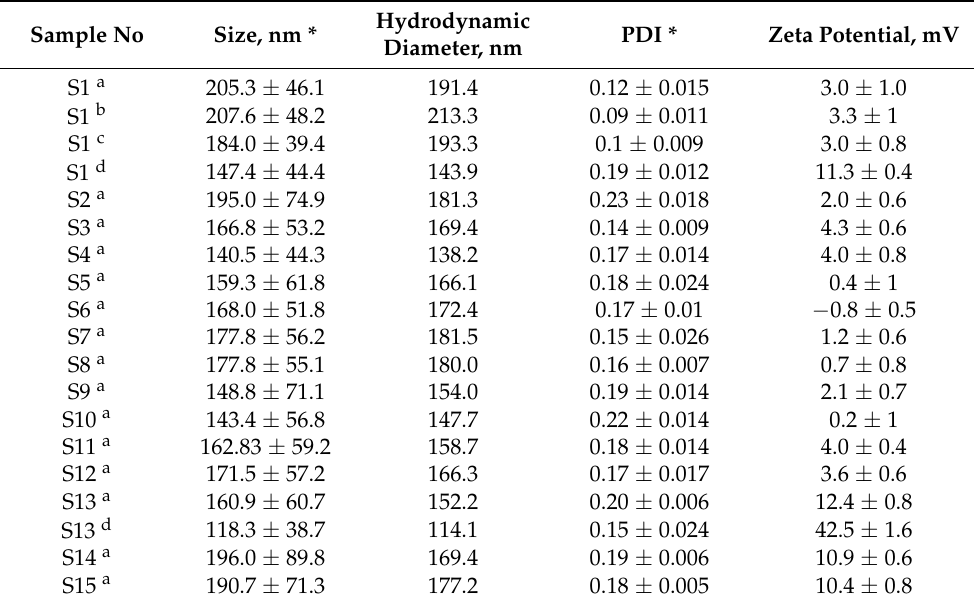
Table 2. Characteristics of lipid